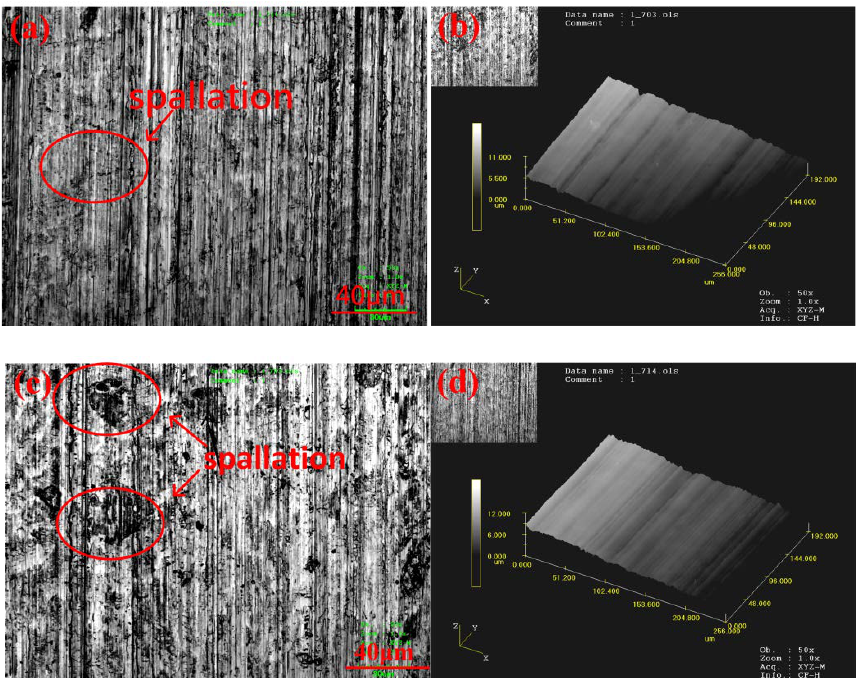
Figure 6. Flat and three-dimensional (3D) laser morphologies of the worn surfaces of the A1 and A2 samples: ( a , b ) show the A1 sample; while ( c , d ) show the A2 sample.